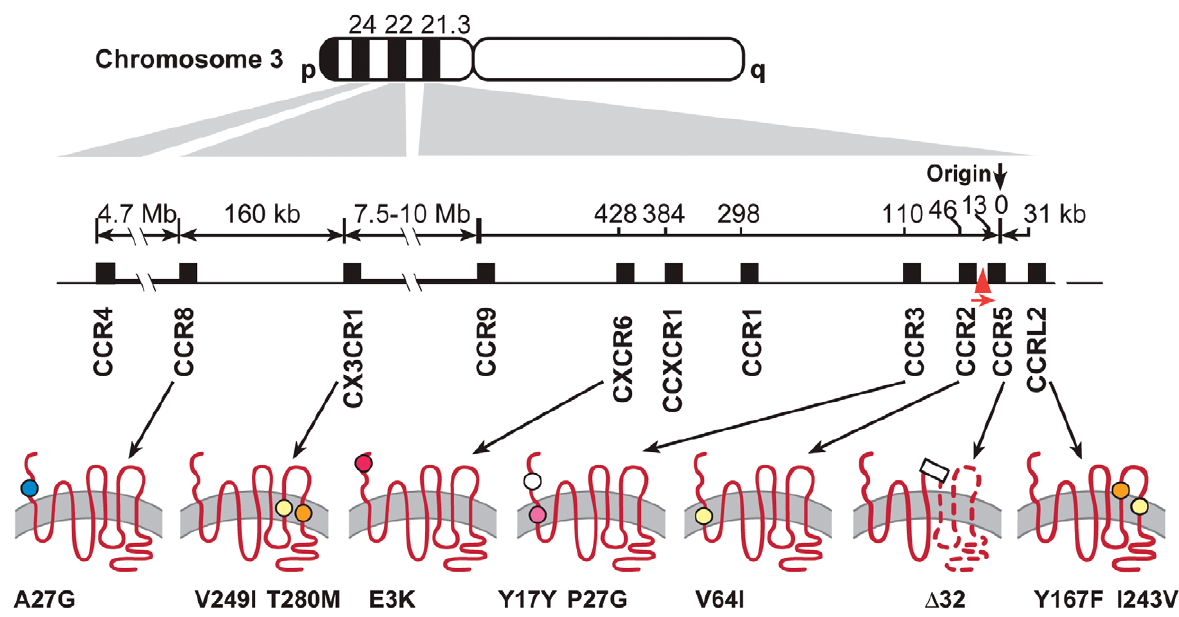
Figure 1. Polymorphisms in seven chemokine receptor genes on the Chromosome 3p21–22. Schematics at bottom show the configuration of the receptors in the cell membrane, with circles representing the position and type of the polymorphisms. White circle indicates a synonymous substitution, colors nonsynonymous substitutions: yellow, conservative; blue, hydrophobic—hydrophilic; orange, hydrophilic— hydrophobic; red, charge changing (acidic—basic), purple, shape changing. Also indicated are D 32 in CCR5 (rectangle) and the polymorphic CCR5 promoter (red triangle in the gene map). CCR5 -2459 promoter allele (rs1799987).